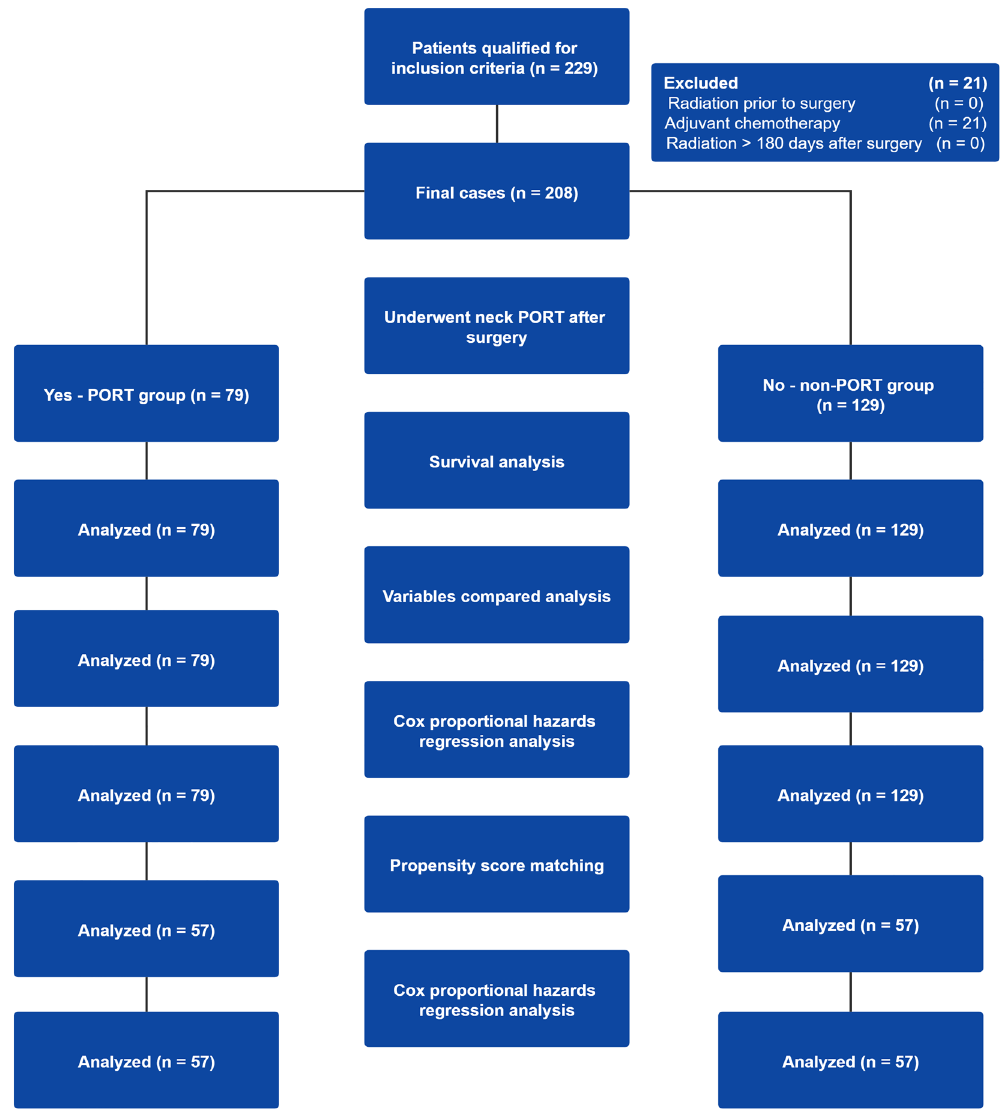
Figure 1. Study profile of the number of patients qualified and number analyzed in the PORT group and non- PORT